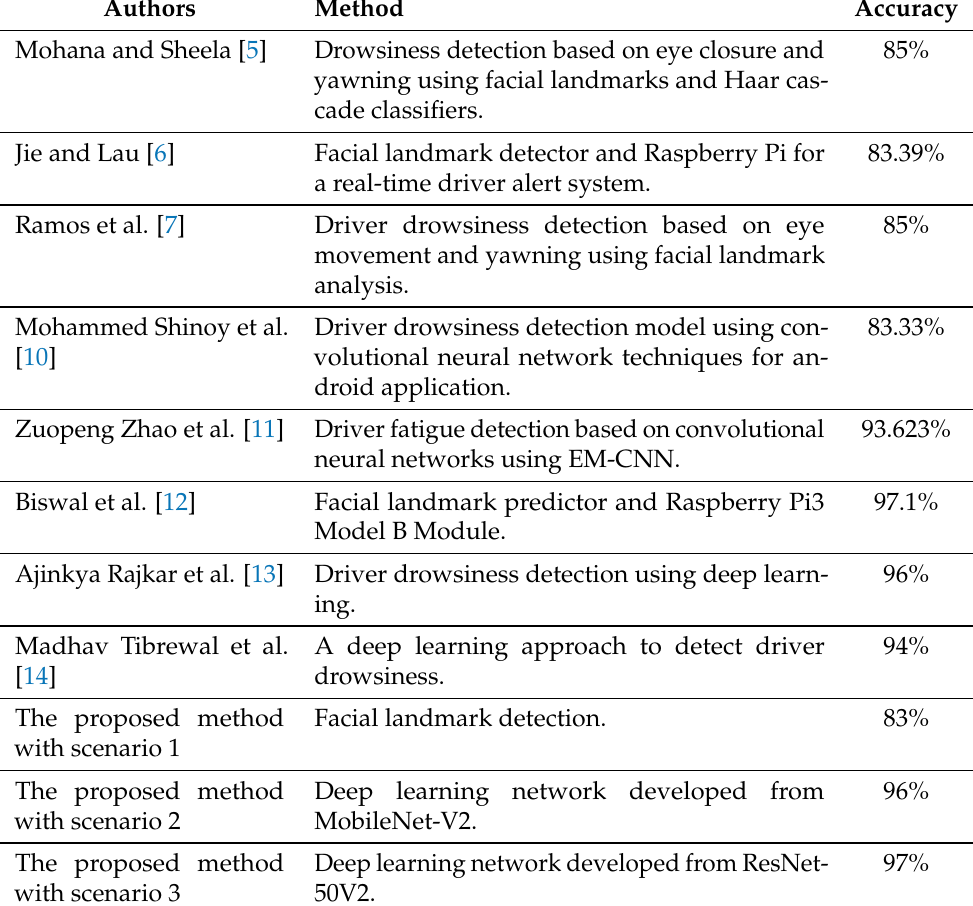
Table 9. Accuracy comparison of drowsiness detection